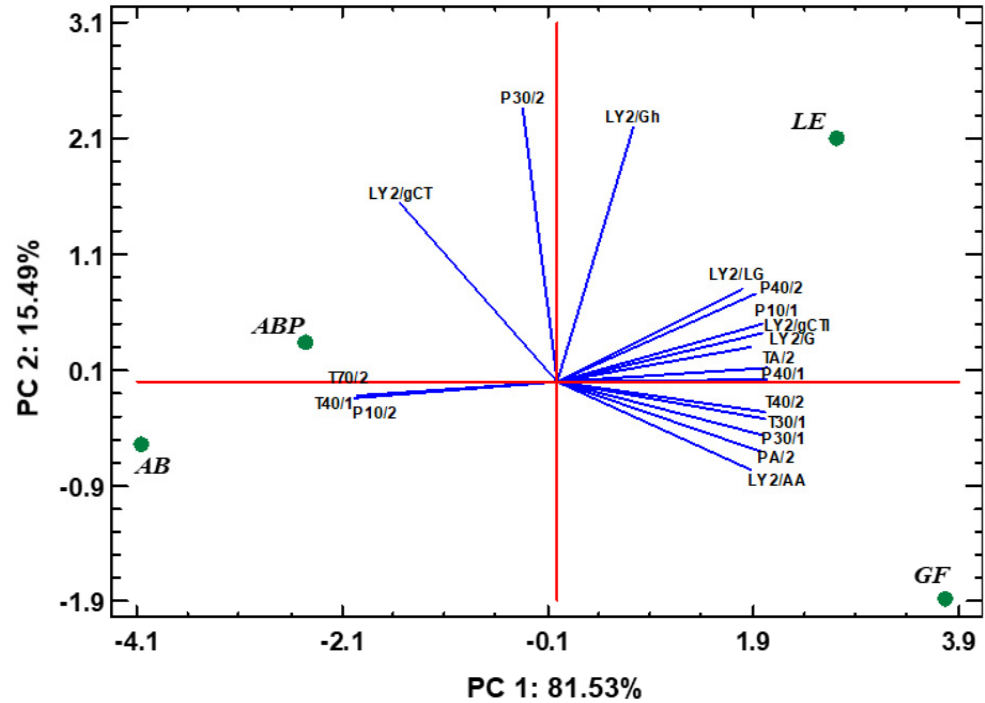
Figure 2. Multivariate analysis (principal components analysis) corresponding to the odor profile of the four different freeze-dried mushrooms evaluated by the response intensity of 18 sensors (variables) from an α -FOX electronic nose (AB, Agaricus bisporus sp. bisporus ; ABP, Agaricus bisporus sp. brunnescens ; LE, Lentinula edodes ; GF, Grifola frondosa ). Blue lines depict the intersection between the red axes, PC1 and PC2, and the PCs of the signal intensity detected by each